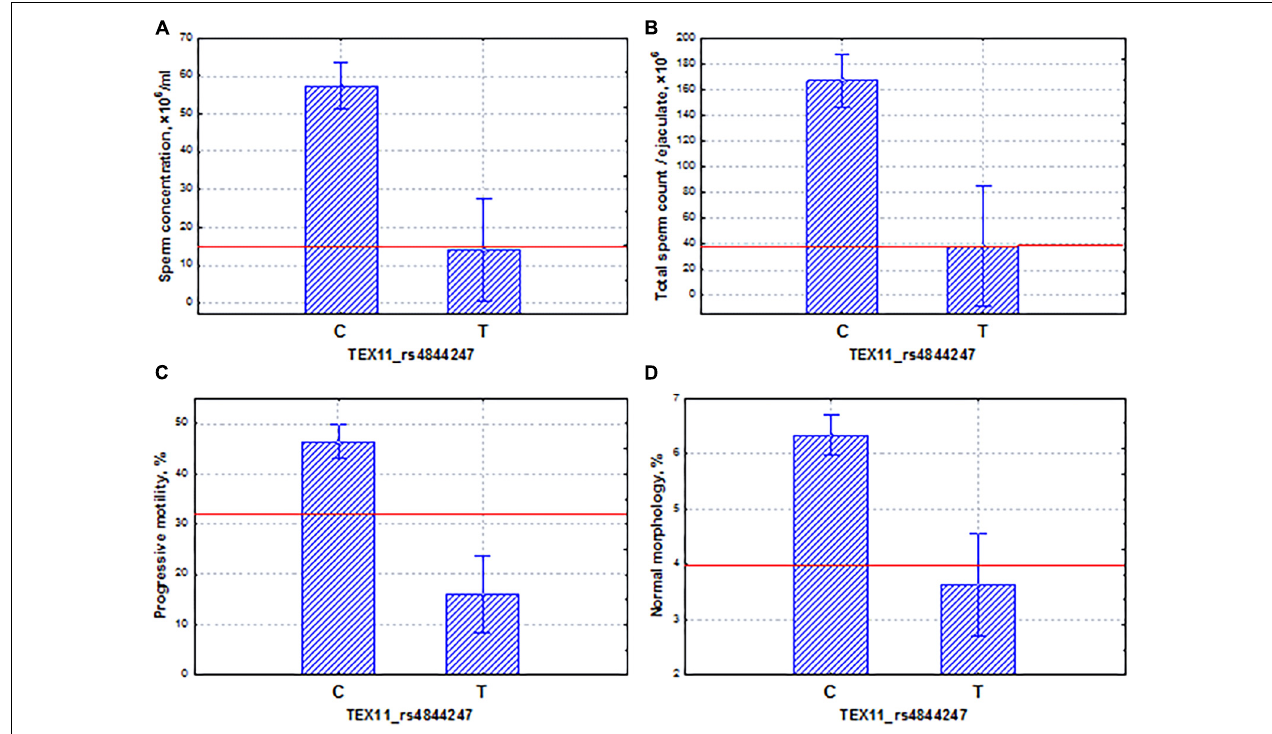
FIGURE 8 | Coordinated allelic effects of the SNP marker rs4844247 of the TEX11 gene on semen quality parameters. (A) Sperm concentration, (B) total sperm count, and (C) proportion of motile, and (D) morphologically normal sperm. All the allelic differences were highly significant ( p < 0.005). The red lines indicate the WHO reference limits for different normal semen parameters [World Health Organization (WHO),